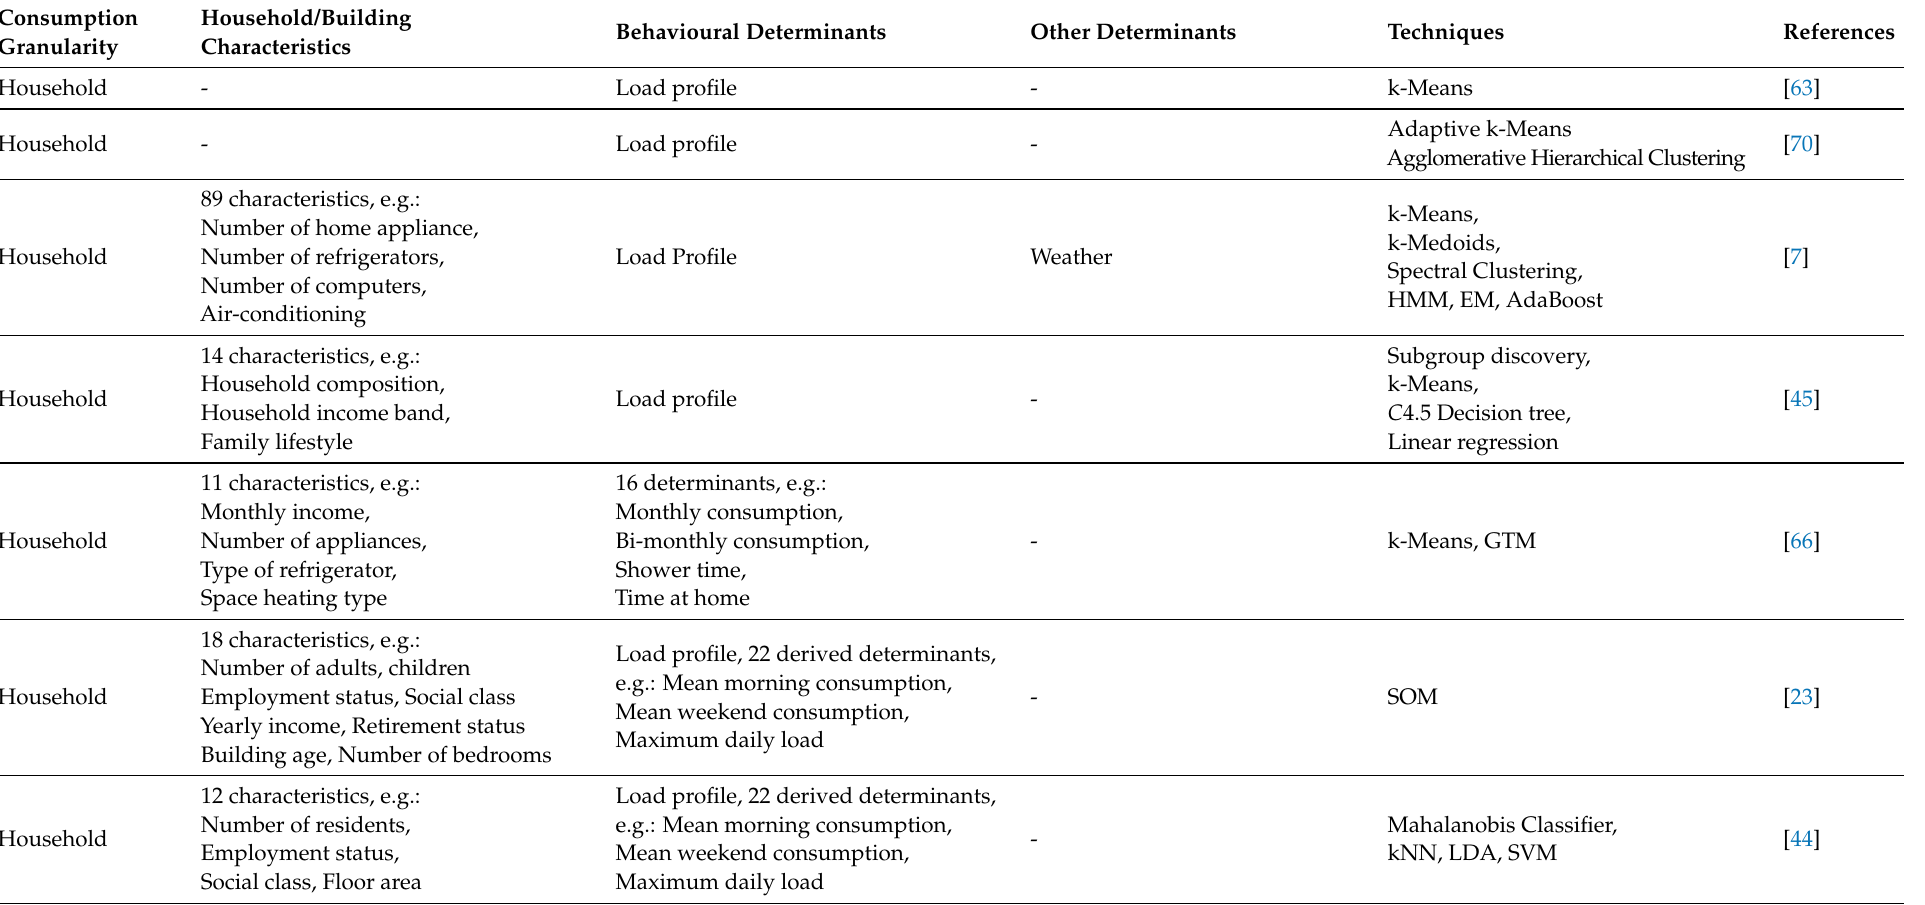
Table 3. A summary of research works on clustering and classification of households and buildings considering